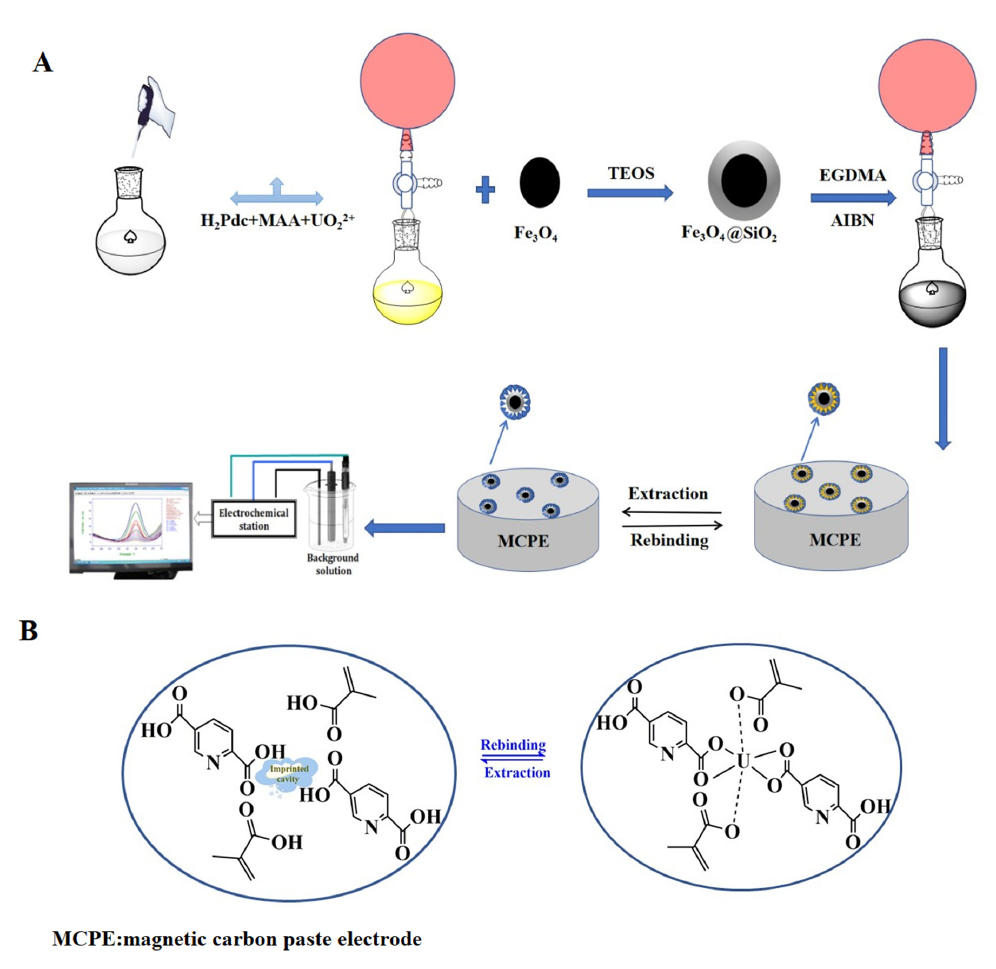
Figure 1. Diagrammatic sketch of ( A ) the preparation of MIIP/Fe 3 O 4 @SiO 2 /MCPE sensor; ( B ) the MIIP/Fe 3 O 4 @SiO 2 /MCPE sensor template extraction-rebinding